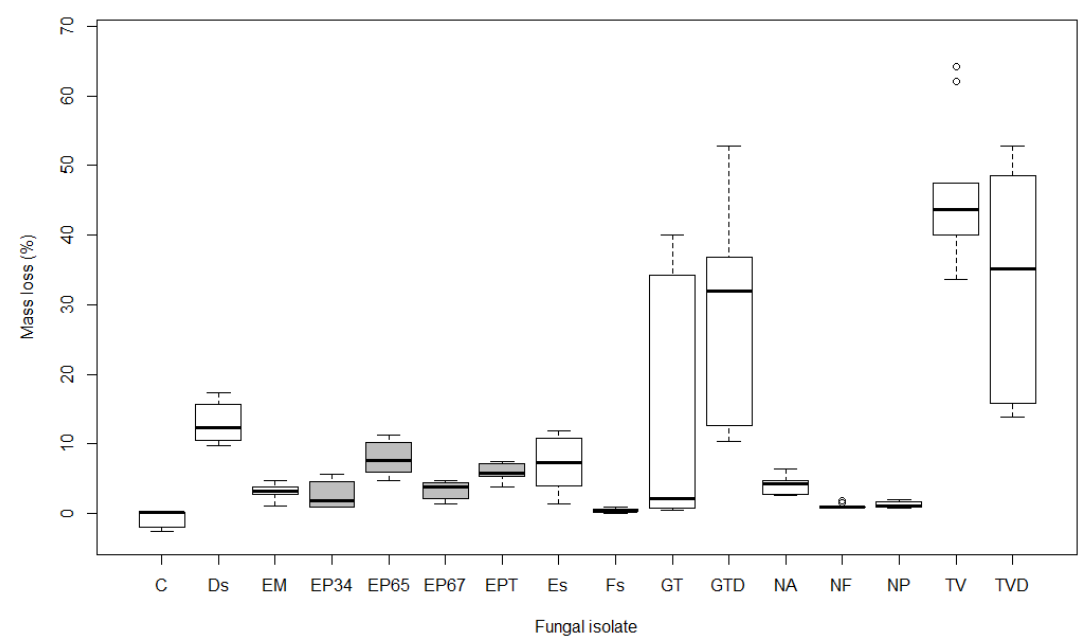
Figure 2. Boxplot showing mass loss (%) after 15 weeks of exposure to different fungal isolates in Acer platanoides (see Table 1 for labels of isolates; boxes of E. parasitica isolates are grey). Boxplot represents minimum, first quartile (Q 1 ), median, third quartile (Q 3 ), and maximum value.